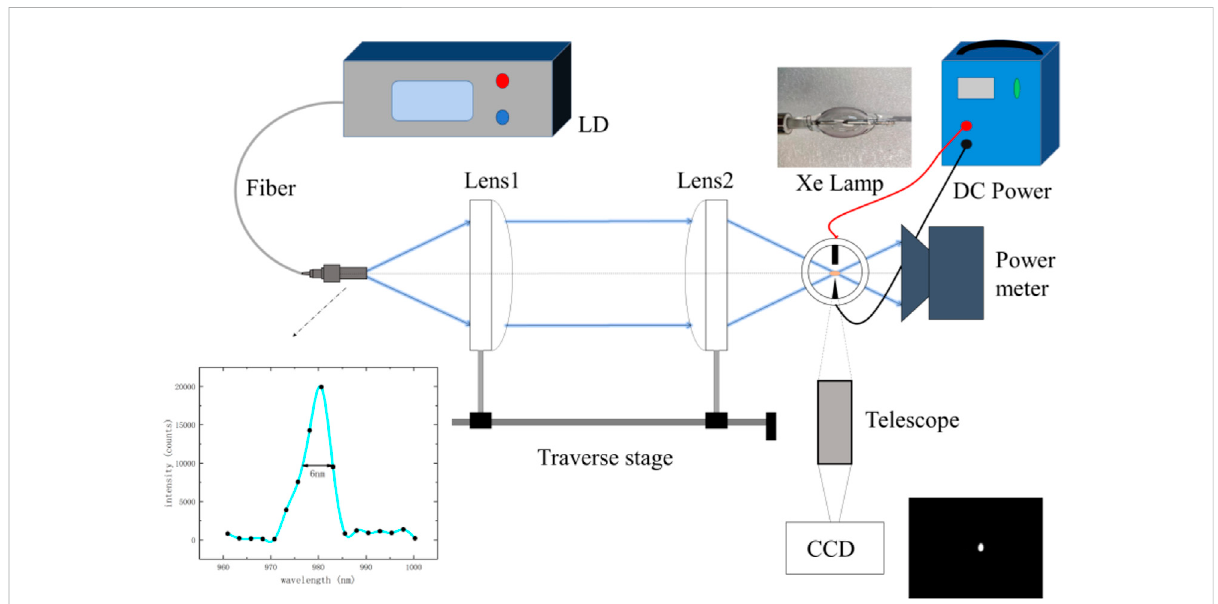
FIGURE 1 Experimentalschematic diagram. Thenear-infraredsemiconductorlaser (illustrated asthespectrumofthecentralwavelength,FWHM isabout 6 nm, and the laser can reach a maximum power of up to 70 W), after being collimated and focused by a position adjustable lens group, enters the middle of the electrode of the xenon lamp with a diameter of 18 mm and a pressure of 12 atm. The bulb is externally connected with a high-voltage arc excitation device to form the initial plasma (this voltage will be removed after laser injection) and uses a power meter (F150A-BB-26, Ophir) and a CCD camera (MV-CA016-10UM, Hikrobotics) to record the laser spot and plasma